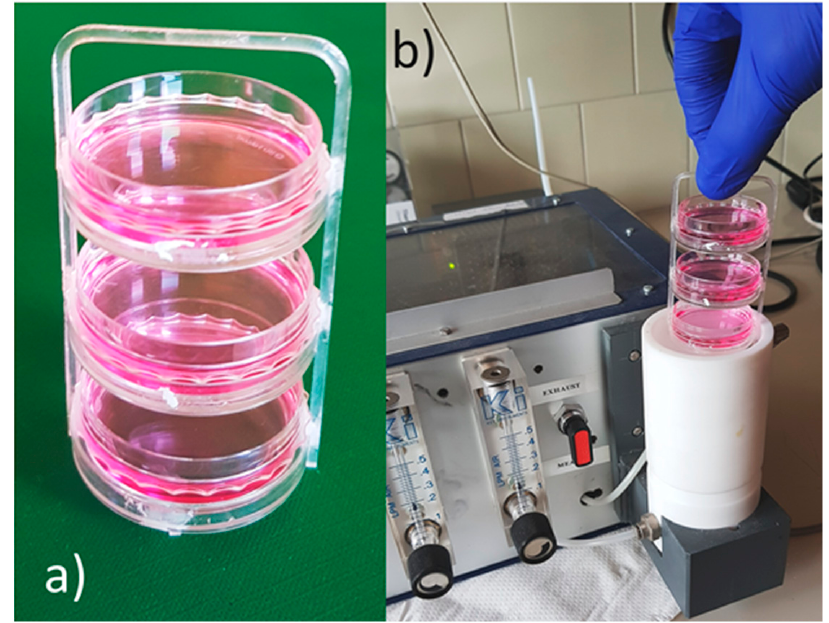
Figure 6. Sample insertion into the device. ( a ) Three petri dishes containing the cells, or the culture medium only, positioned in the holding tray; ( b ) the tray holding the three petri dishes being placed in the SCENT B1 sample chamber.